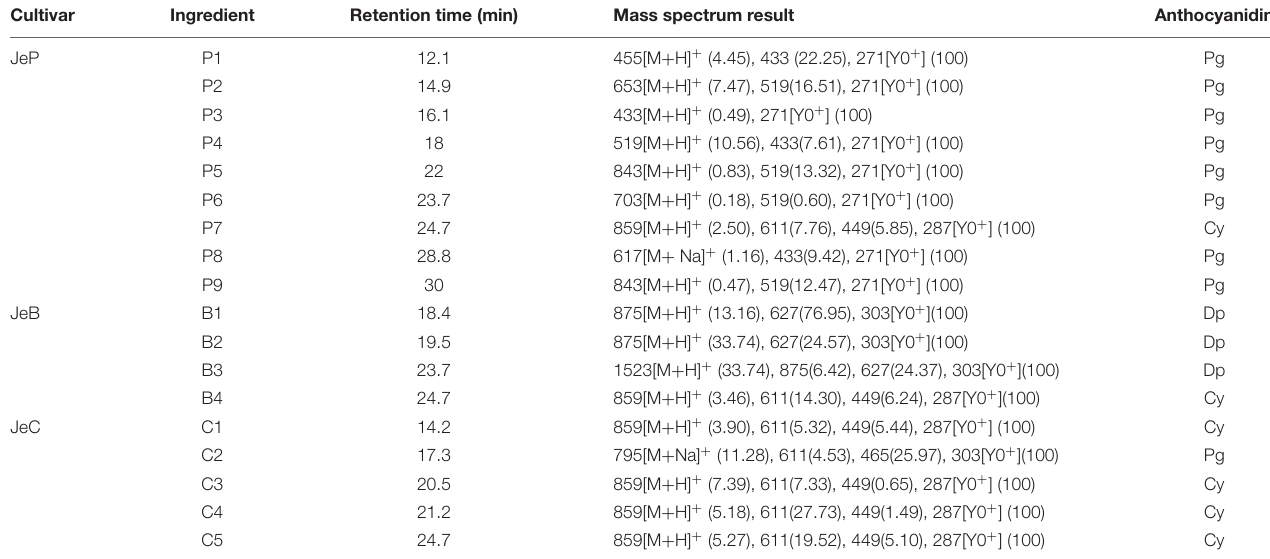
TABLE 2 | Structure identification of anthocyanidins in colored cultivars. Cultivar Ingredient